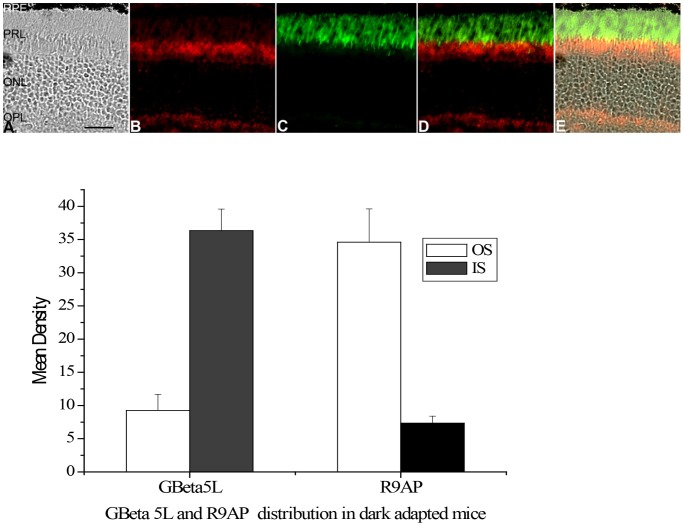
Double labeling studies using anti-Gβ5L and anti-R9AP antibodies on a dark adapted mouse retina isolated and processed in complete darkness.Upper panel: A: the DIC image of an 8-hours dark adapted mouse retinal section indicates structural integrity of rod outer segments. This retinal section was used for a double-immunostaining of Gβ5L and R9AP. This figure clearly shows that, after prolong dark adaptation; Gβ5L is located primary in rod inner segments (B) while R9AP is always located in rod outer segments (C). D: Double-immunostaining (Merge) of Gβ5L and R9AP in the same region. E: Merge of Gβ5L and R9AP under DIC image. Lower panel: Analysis of the average levels of Gβ5L and R9AP in the outer segment layer (OS) and inner segment layer (IS); n = 8. Labels are the same as in Fig. 1.